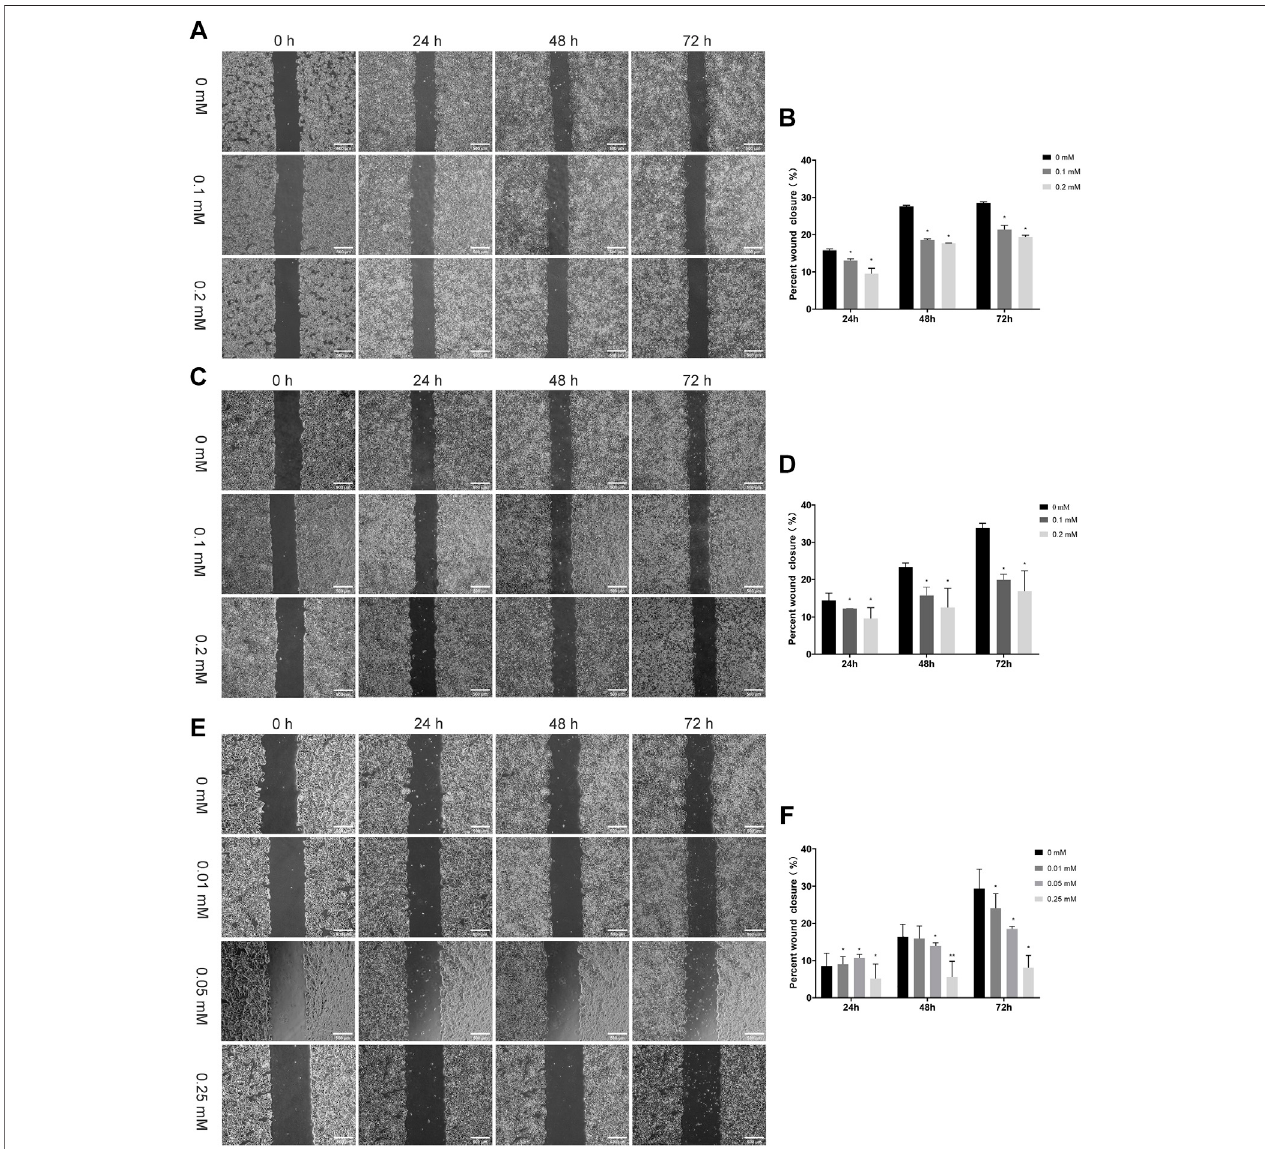
FIGURE8| ScratchAssays (A,B) Cal27cellsweretreatedwithdifferentconcentrationaspirin(0.1,0.2 mM),thescaleis500 μ m (C,D) Indomethacin(0.1,0.2 mM), the scale is 500 μ m and (E,F) Nimesulide (0.01, 0.05, 0.25 mM), the scale is 500 μ m. Photographs were taken immediately after the formation of the scratch and when 24 h, 48 and 72 h later. The relative scratch covered area was quanti fi ed by ImageJ, * p < 0.05, ** p < 0.01. The data were presented as the mean ± SD (n (cid:1) 3).